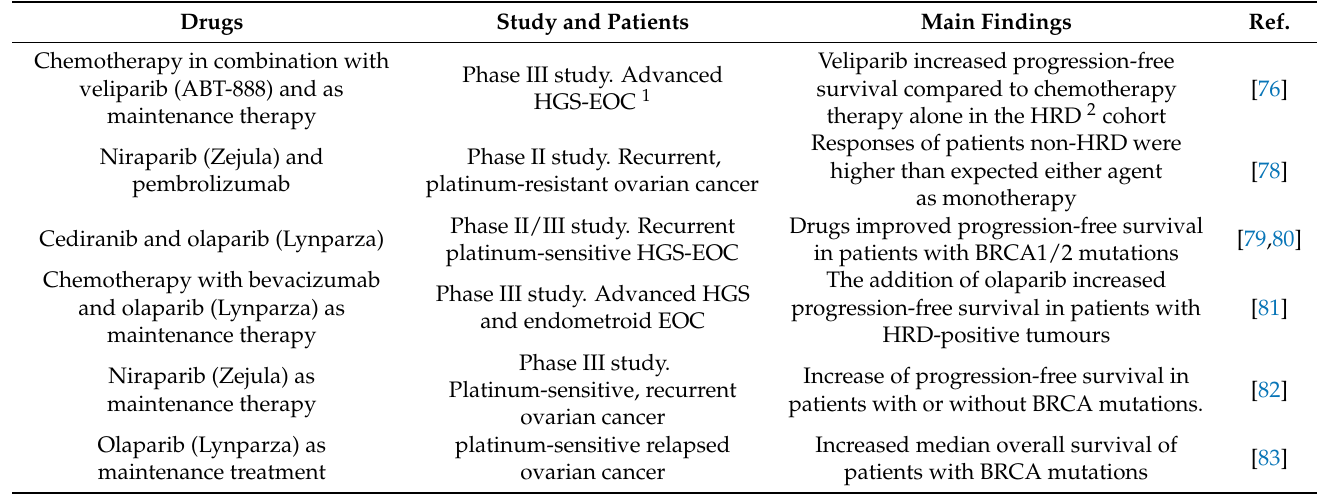
Table 1. Summary of latest studies performed with PARP inhibitors in ovarian cancer